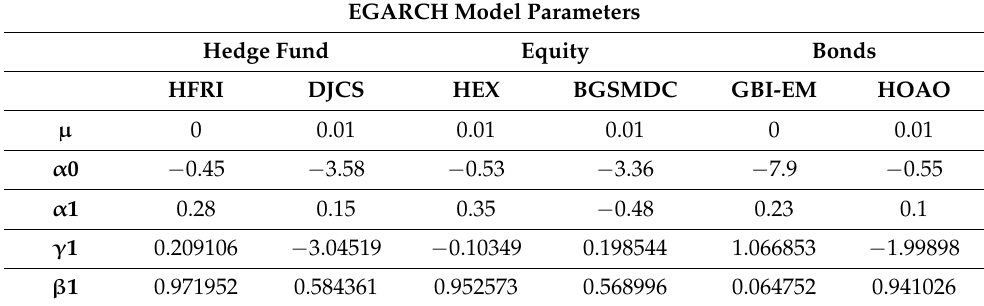
Table 6. EGARCH parameters. Source: